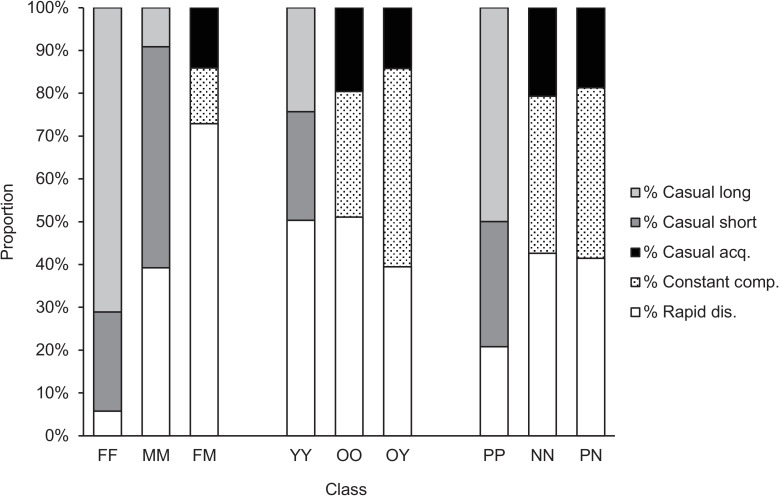
Proportions of components in lagged association rate models among 44 adult mule deer in Saskatchewan, Canada.FF = female-female pairs, MM = male-male pairs, FM = female-male pairs; YY = young-young pairs, OO = old-old pairs, OY = old-young pairs; PP = positive-positive pairs, NN = negative-negative pairs, and PN = positive-negative pairs. Rapid disassociations were associations that lasted the sampling period (i.e. 1 day) at most. In constant companionships, the probability of re-association did not decay or increase over time within the context of the study period (i.e. 1 year). In casual acquaintances, the probability of re-association decayed over time, and their rate of decay was approximated from a1. In some cases, LARs of casual acquaintances decreased over 2 different time scales, one lasting longer (casual long) than the other (casual short). For formulae, and results on durations and SE, see S2 Appendix.